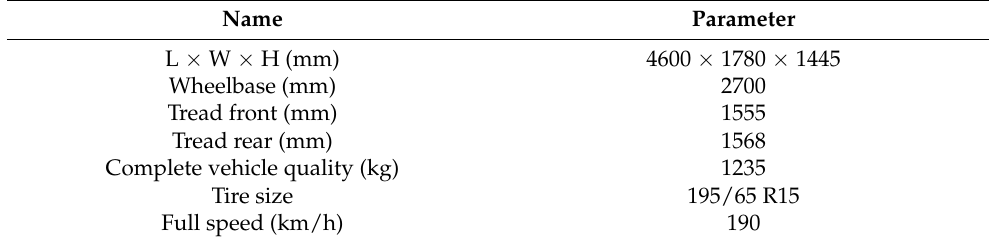
Table 2. Main parameters of test